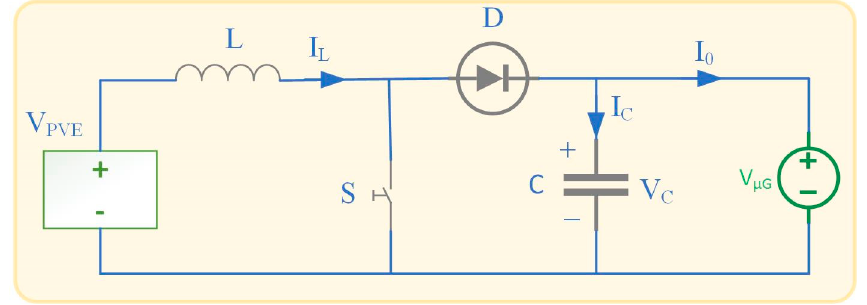
Figure 3. DC–DC boost converter.